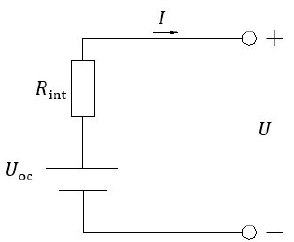
Figure 3. Battery internal resistance model.